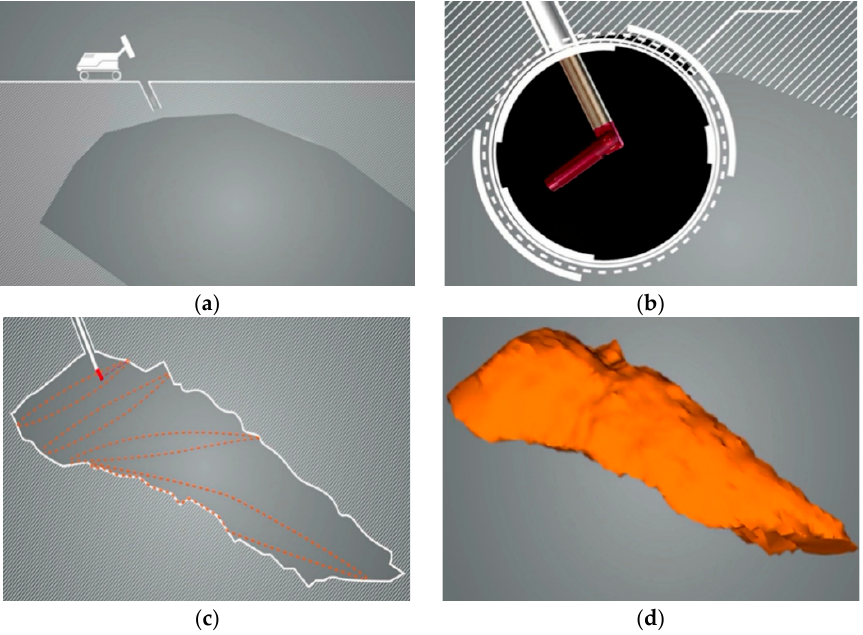
Figure 9. Cavity cloud model acquisition process: ( a ) drilling borehole; ( b ) position adjustment; ( c ) scanning; ( d ) cloud model reconstruction.